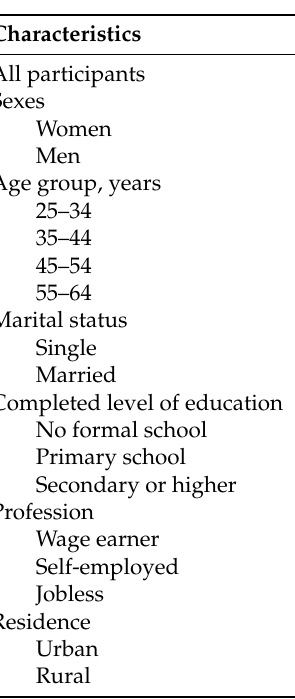
Table 1. Sociodemographic profile of the study